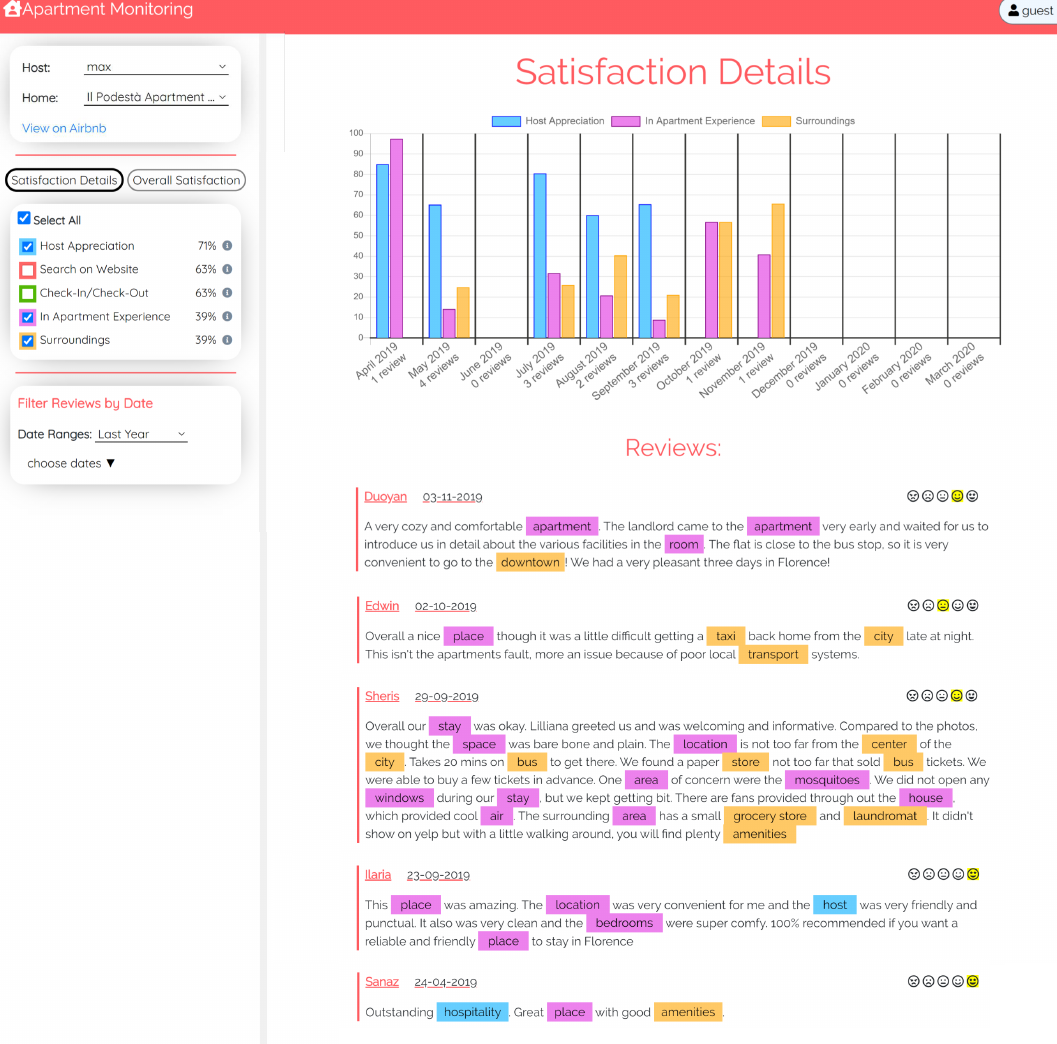
Figure 3. Apartment Monitoring: visualization of consumer satisfaction about a home regarding the host appreciation, in-apartment experience, and surroundings, during the last